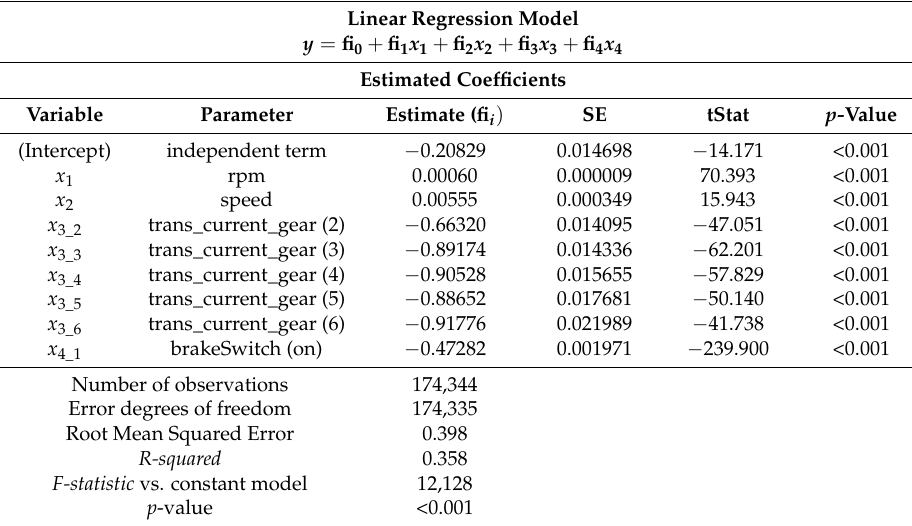
Table 2. Results of the first